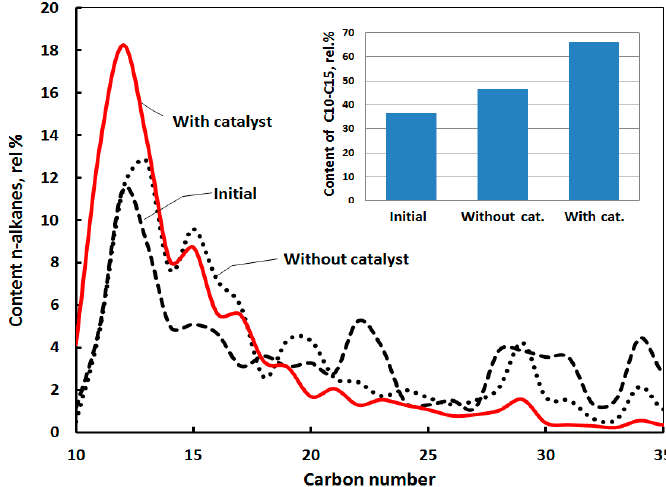
Figure 2. The distribution of n-alkanes in saturated fractions of initial rock extracts, after hydrothermal and thermo-catalytic treatment samples (24 h, 300 °C).